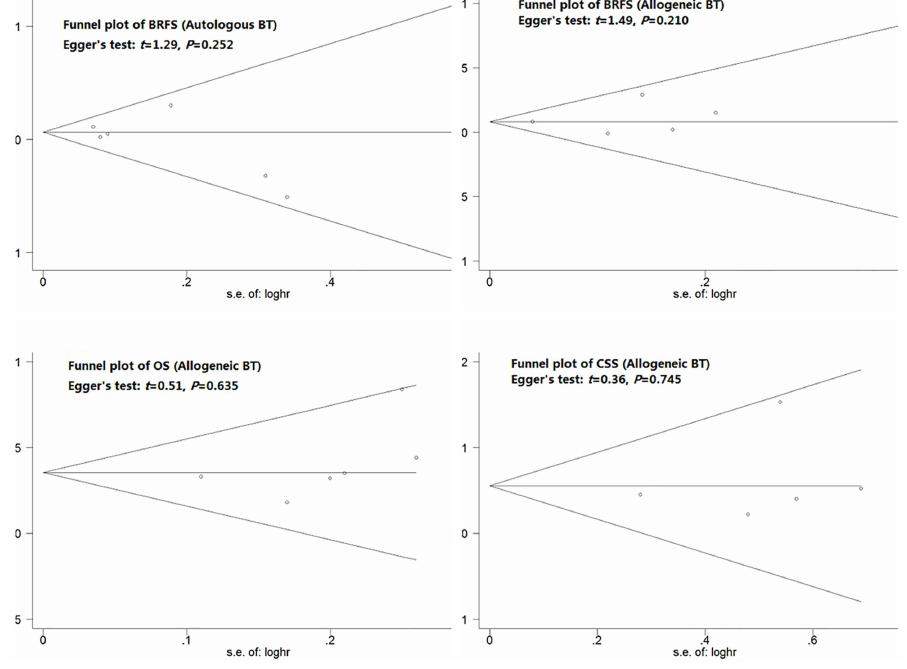
Fig 5. Funnel plot analysis of publication